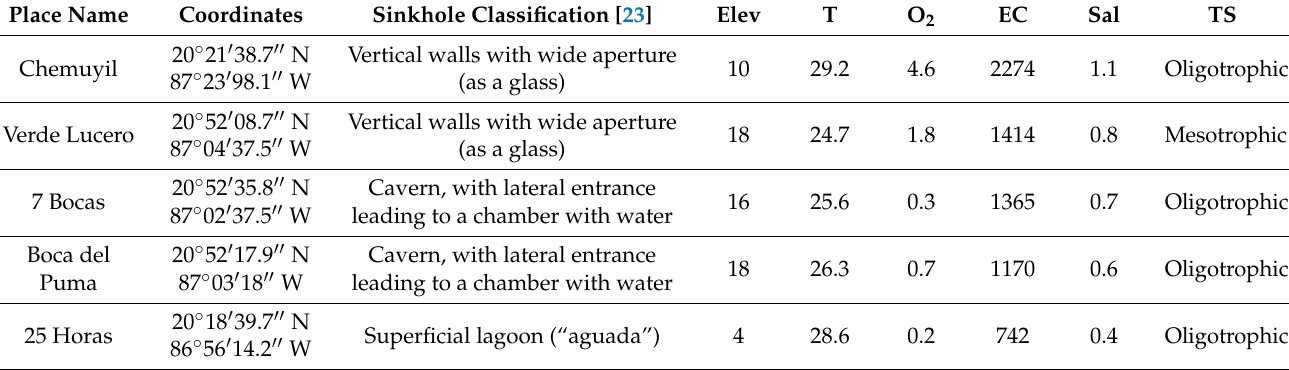
Table 1. Limnological characteristics of the aquatic habitats inhabited by Mastigodiaptomus ha (Quintana Roo, Mexico). Elev = elevation (masl), T = water temperature, O 2 = dissolved oxygen (mg/L), EC= electrical conductivity ( µ S/cm 3 ), Sal = salinity (ppt), TS = trophic state.